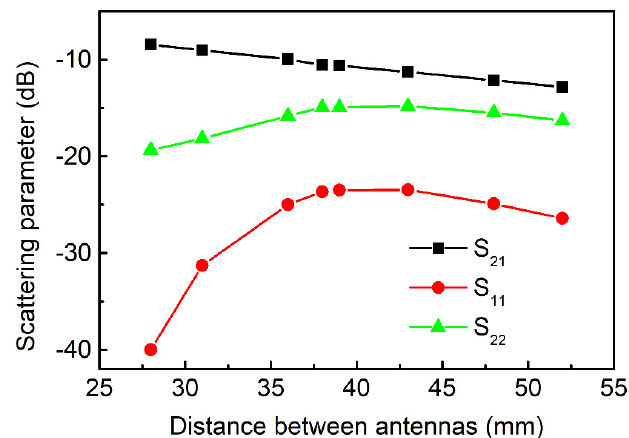
Figure 5. Scattering parameters S 21 (black squares), S 11 (red dots) and S 22 (green triangles) versus the distance between the antennas. Measurements are done at peak frequencies close to 4.8 GHz, i.e., the shallowest points for S 22 and S 11 , and the highest ones for S 21 .